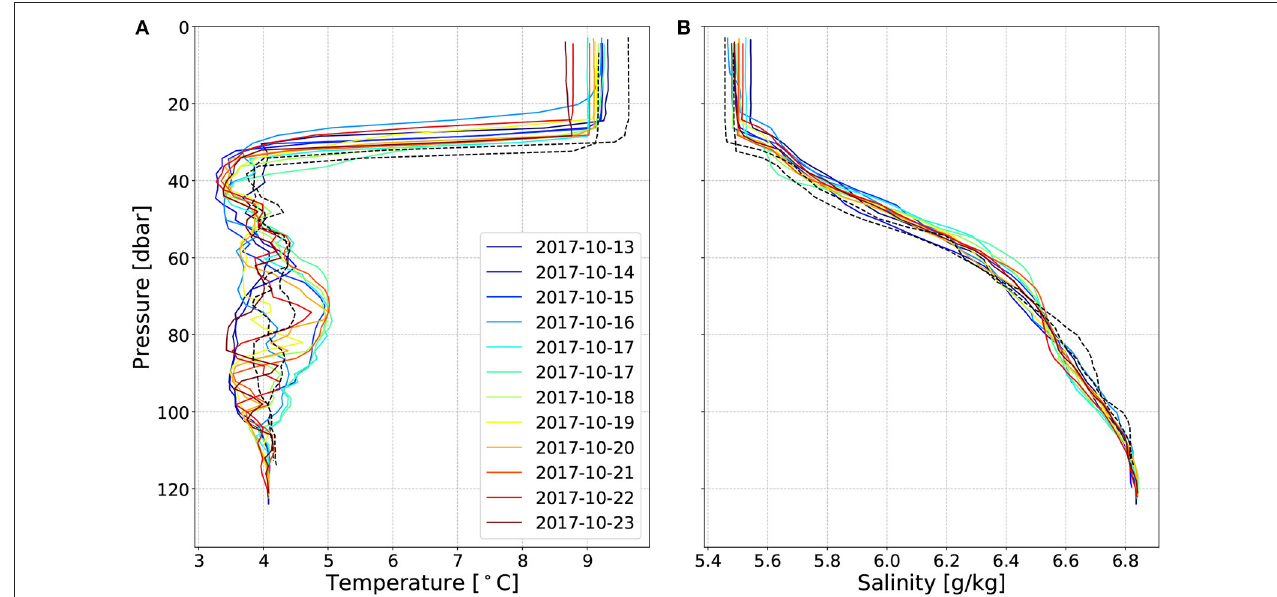
FIGURE 8 | (A) Temperature and (B) salinity profiles measured by float 6902029 between 13.-24.10.2017. The dashed black lines show the profiles from float 6902028 from the same time period.